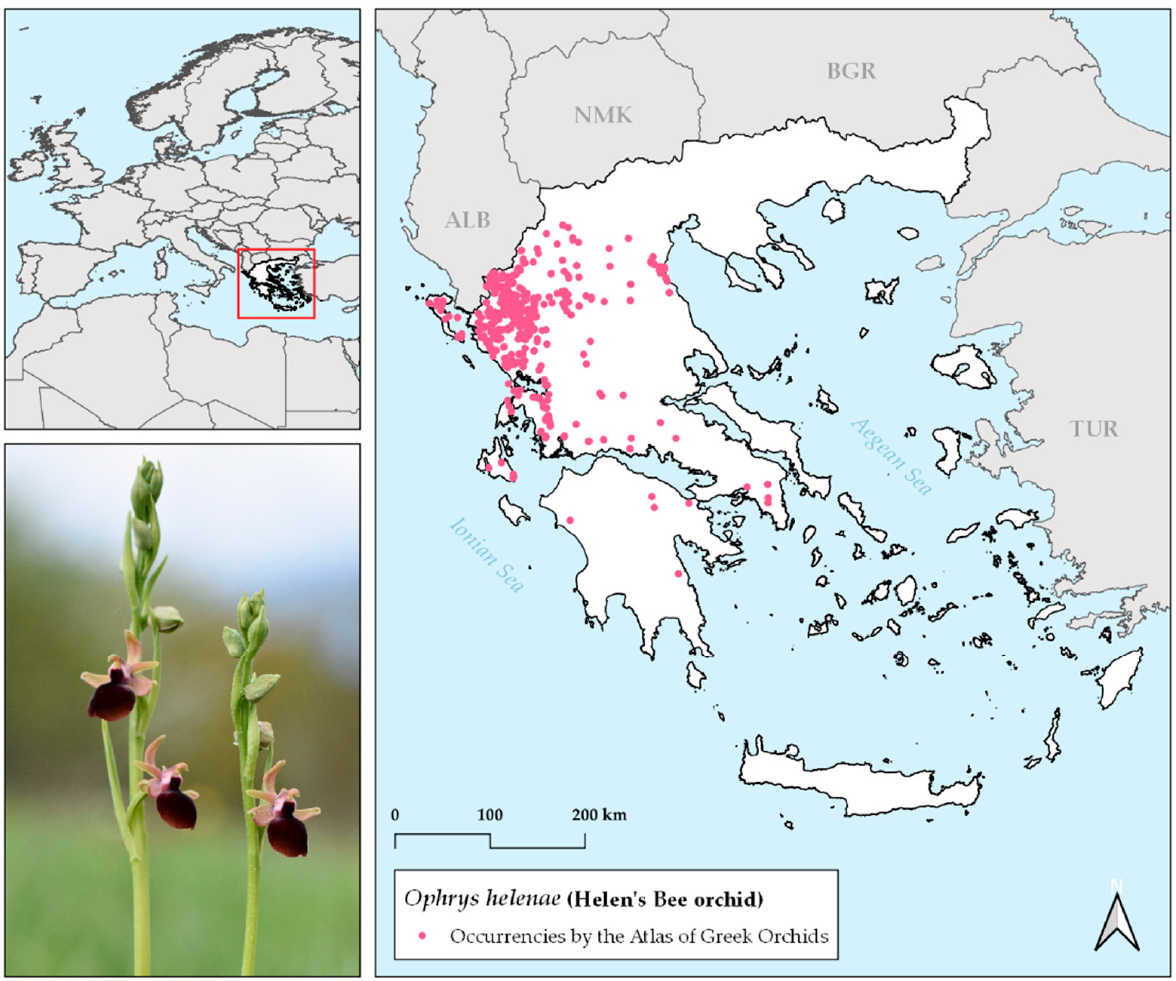
Figure 5. Occurrences of Helen’s bee orchid in Greece, according to the database of the Orchid Flora of Greece project (Atlas of Greek Orchids [40]). Picture of Ophrys helenae individuals blooming in Ioannina, NW Greece, April 2019 (photo credits: Kalliopi Stara).